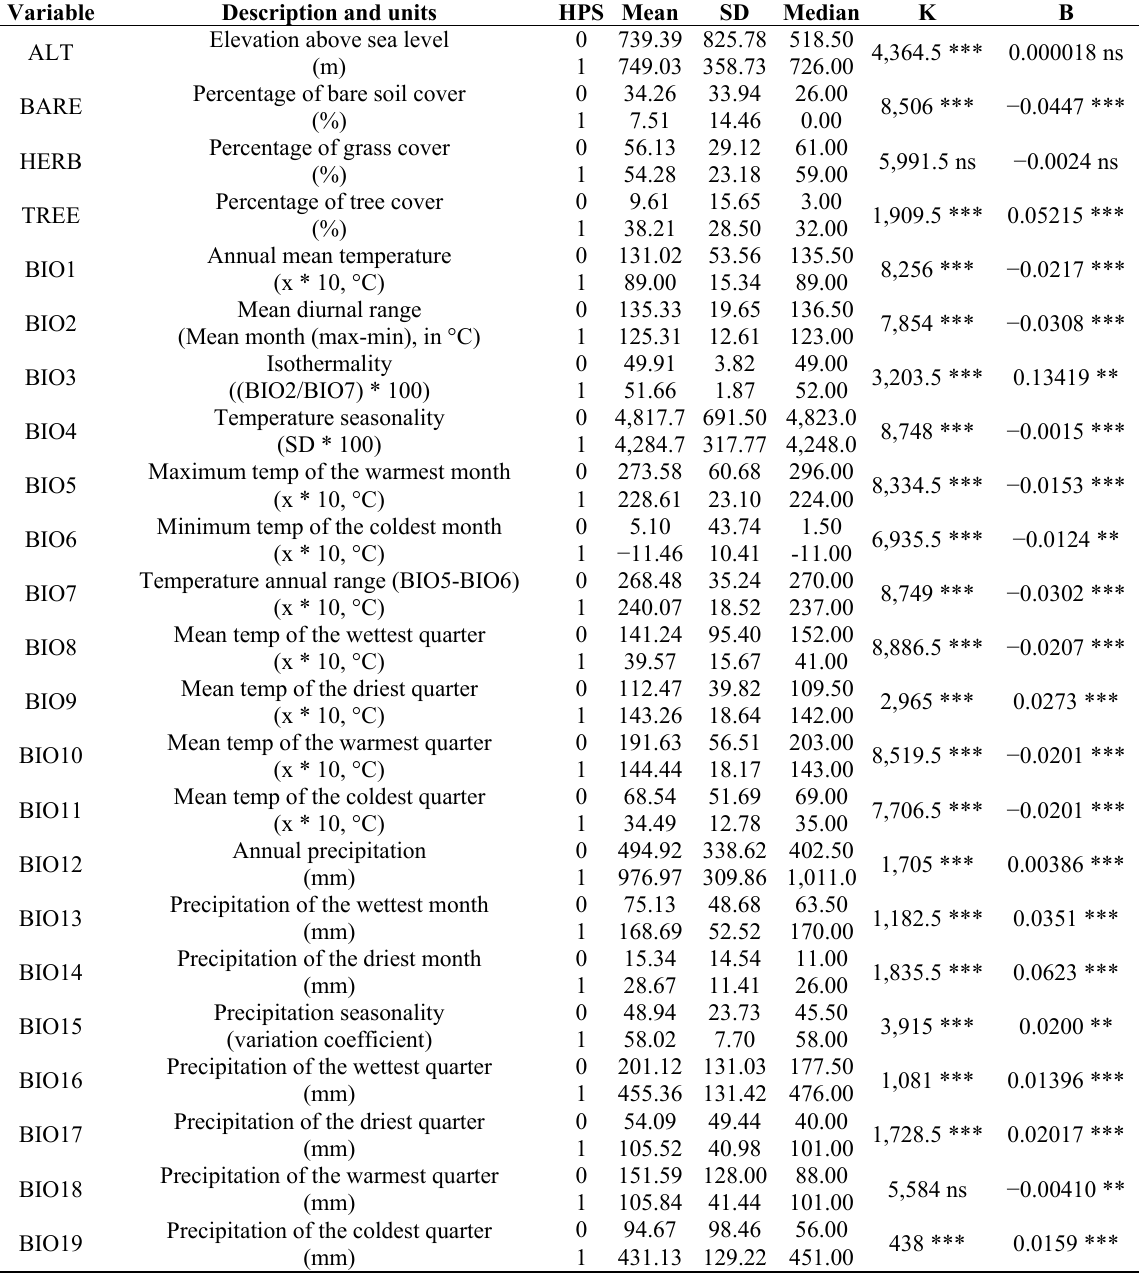
Table 1. Univariate statistics for the environmental variables considered in sites with and without HPS cases by Andes virus in southern